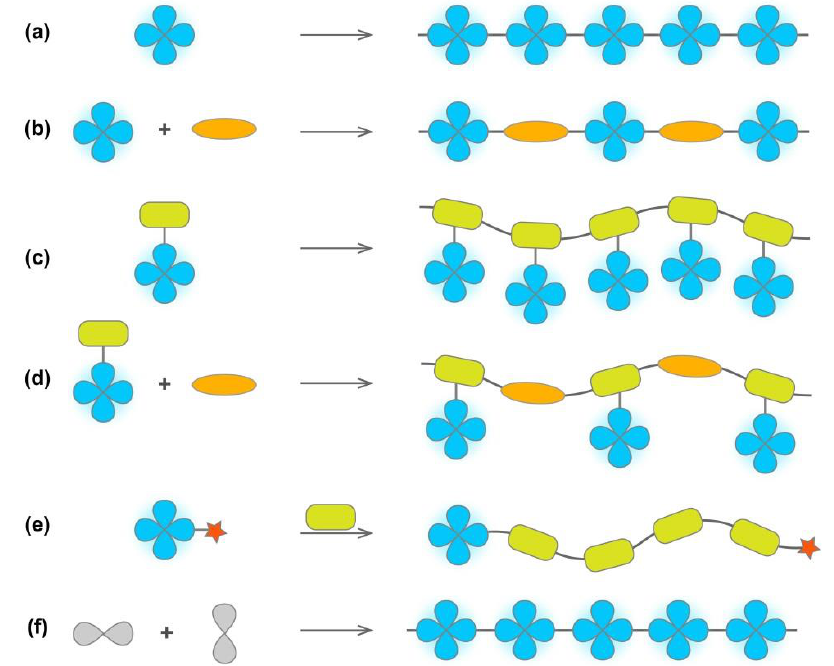
Figure 2. Construction strategies of AIE-active polymers. ( a ) Direct polymerization of AIE-active monomers and ( b ) copolymerization of AIE-active monomers with other monomers to embed AIEgens into the main chain of polymer. ( c ) Homopolymerization and ( d ) copolymerization to introduce AIEgens into the side chain of polymer. ( e ) AIEgens served as an initiator to initiate polymerization. ( f ) Polymerization of AIE-inactive precursors to obtain polymers with AIE property.